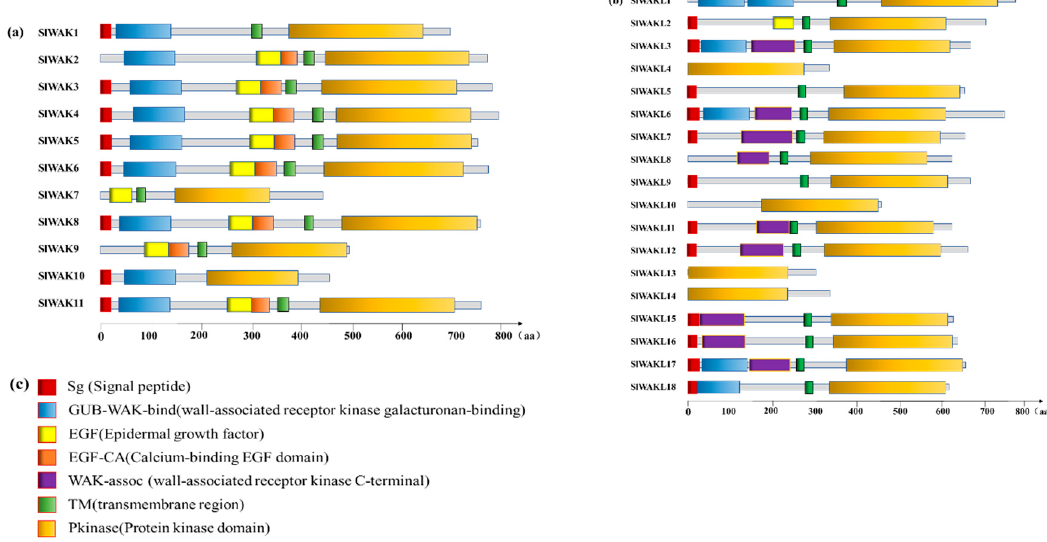
Figure 1. Structure of the tomato SlWAK-RLK proteins. Different structural domains are represented by different color blocks, the specific details have been marked in the figure. Scale bar represents 800 amino acids. Domains were identified using SMART (http://smart.embl-heidelberg.de/). ( a ) Structure of the tomato SlWAK proteins; ( b ) Structure of the tomato SlWAKL proteins; ( c ) The domains found in these SlWAK-RLK proteins.